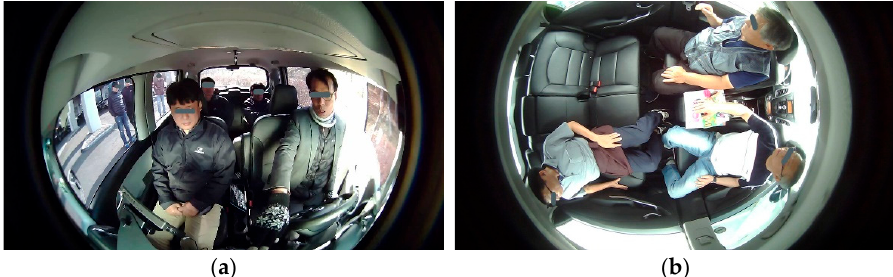
Figure 11. Example image representing the comparison of camera positioning: ( a ) FF monitoring camera; ( b ) The proposed camera installed at the center of the RT of AV. The FF camera captures both in-cabin and outside. The camera installed at the center of the RT of the AV captures only in-cabin. Faces are masked for privacy preservation.